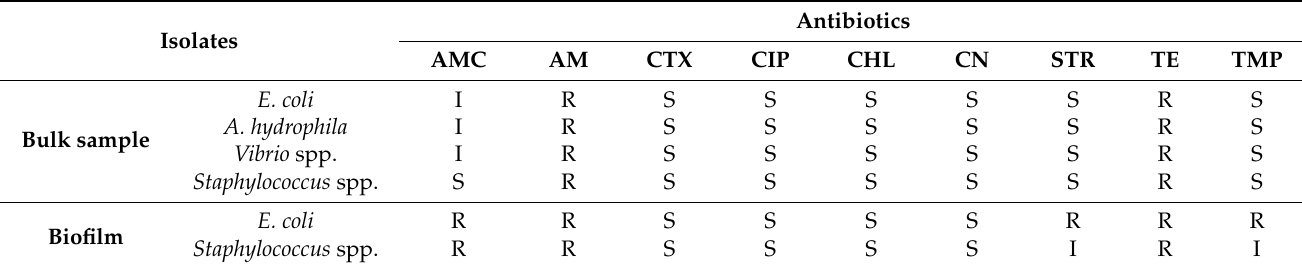
Table 2. Antibiotics susceptibility pattern of the isolates from common